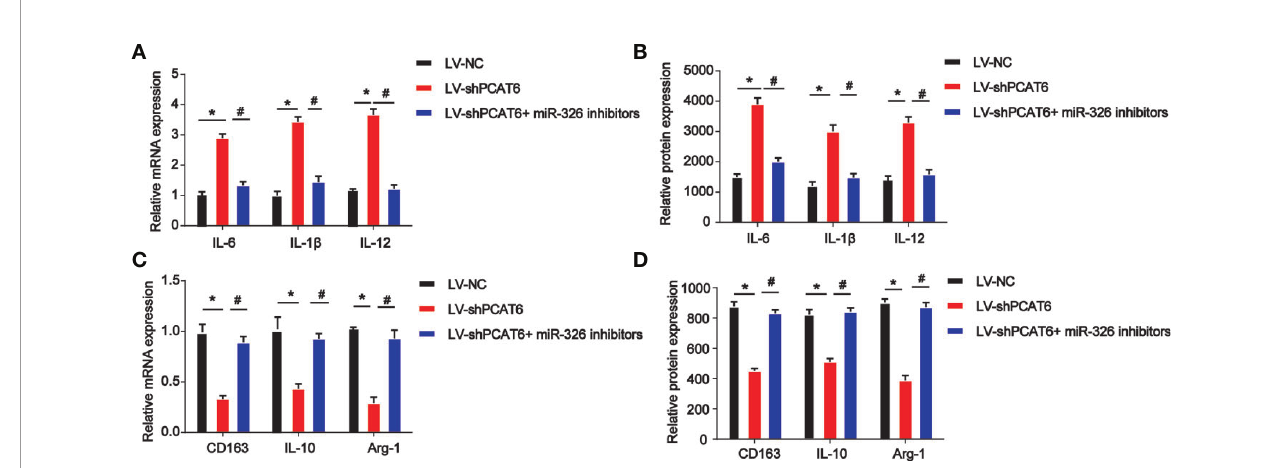
FIGURE 5 | Effects of miR-326 on M2-like polarization of macrophages. THP-1-diferentiated macrophages were infected with PCAT6 short hairpin RNA (shRNA) and miR-326 inhibitors. (A) The messenger RNA (mRNA) expression levels of IL-6, IL-1 b , and IL-12 were determined by qRT-PCR in THP-1-differentiated macrophages. (B) The protein expression levels of IL-6, IL-1 b , and IL-12 were determined by ELISA assay in THP-1-differentiated macrophages. (C) The mRNA expression levels of IL-10, CD163 and Arg-1 were determined by qRT-PCR in macrophages. (D) The protein expression levels of IL-10, CD163, and Arg-1 in THP- 1-diferentiated macrophages. *P < 0.05. Compared with the control group. # P < 0.05. Compared with the LV-shPCAT6